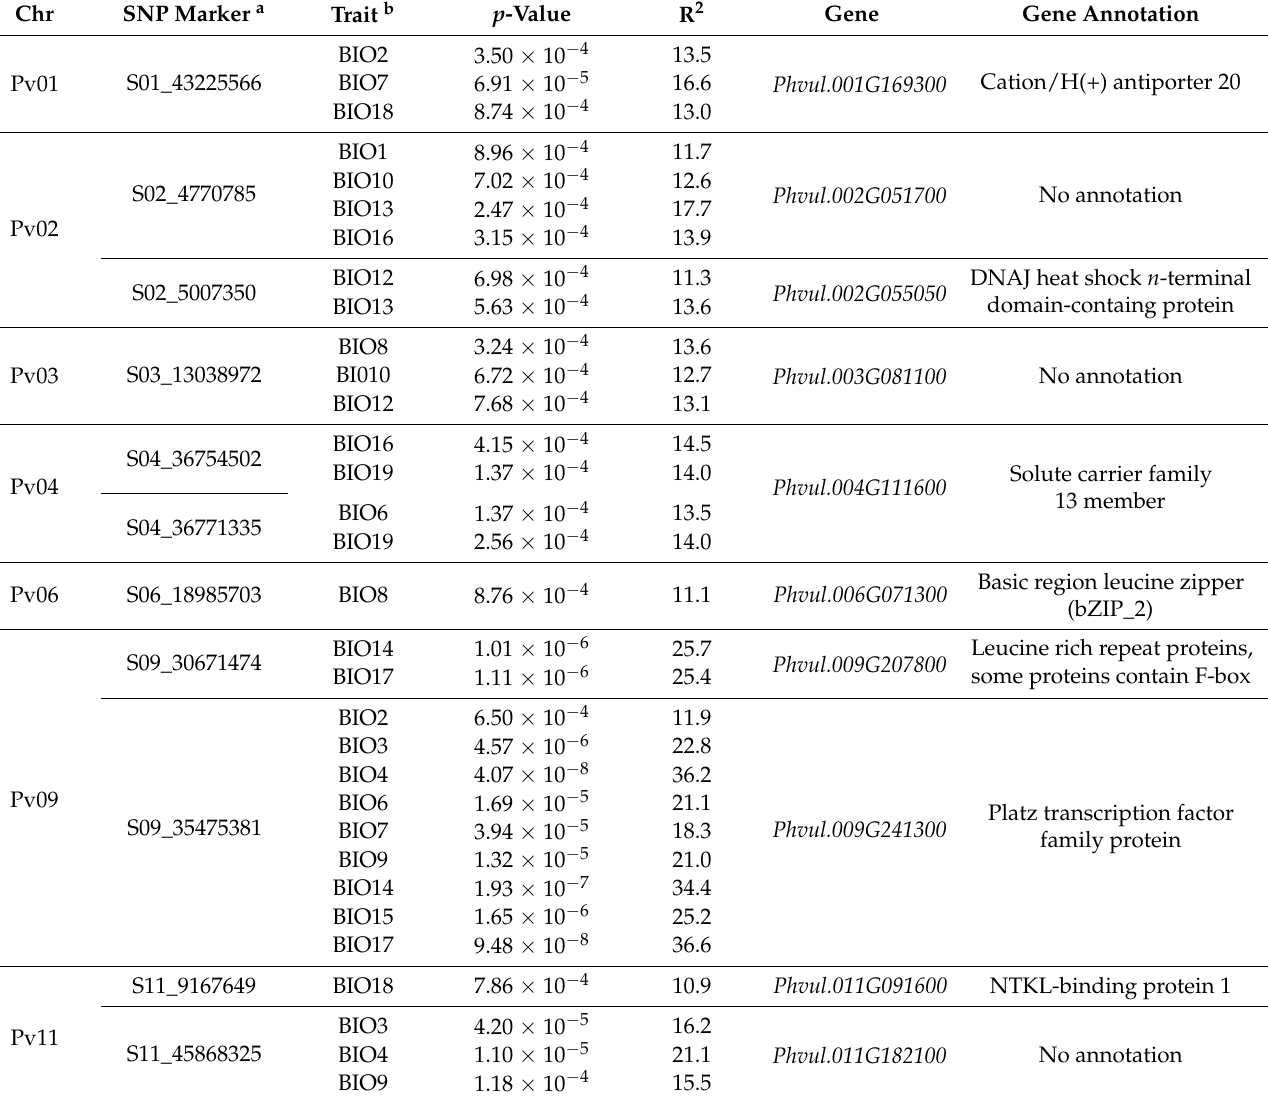
Table 3. Phaseolus vulgaris chromosome (Chr), two most significant single nucleotide polymorphism (SNP) markers, trait, p -value, proportion of the phenotypic variation explained (R 2 ), gene, and gene annotation of 110 common bean accessions. Chr SNP Marker a Trait b Pv01